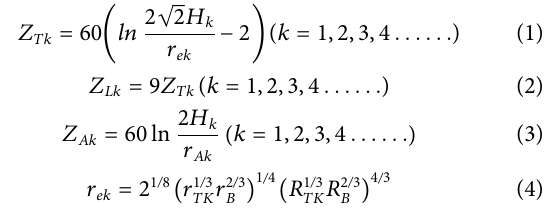
Figure 1 ; the calculation formula of the wave impedance of each part is as follows (Ishii et al., 1991).